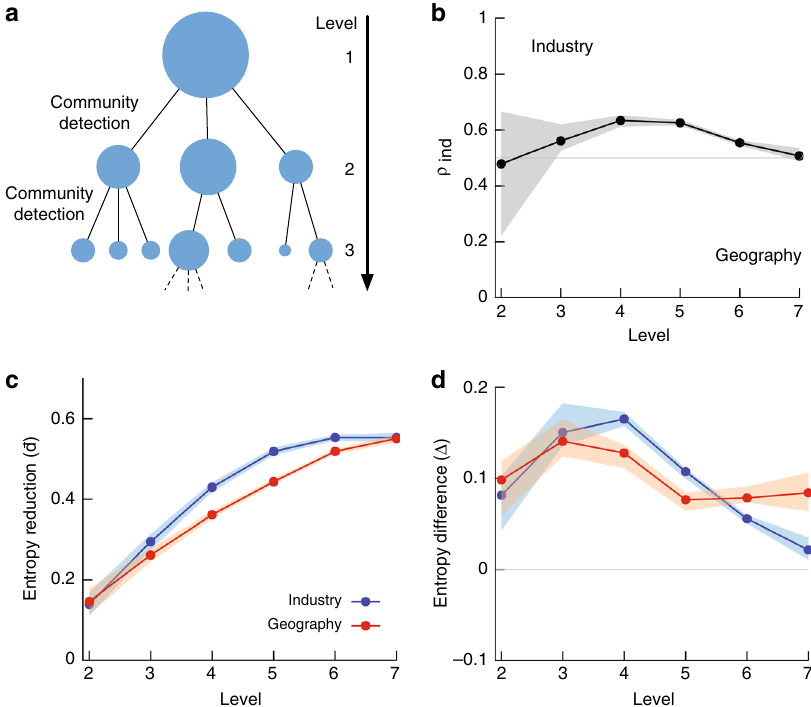
Fig. 2 The impact of geography and industry across scales. The top-level communities of this network found through the Louvain method (see Methods) have a modularity of 0.47. a We recursively apply network community detection to discover the labor fl ow network ’ s hierarchical structure. See Methods for more details. b Both industry and geography affect job transition across all scales, but industry has a more important role in the middle of the hierarchy as seen by the proportion of communities with a greater reduction in industry entropy ( ρ ind ). c The average reduction of metadata entropy (cid:1) d (see Methods for the de fi nition) at each level of the hierarchical community structure, calculated with respect to the whole network. The monotonic increase indicates that smaller communities are more homogeneous as expected. d This entropy reduction is greater than expected by a null model. The difference between the observed entropy reduction and the reduction in a randomized hierarchical null model is denoted as Δ . Positive Δ indicates that the homogeneity of clusters is stronger than